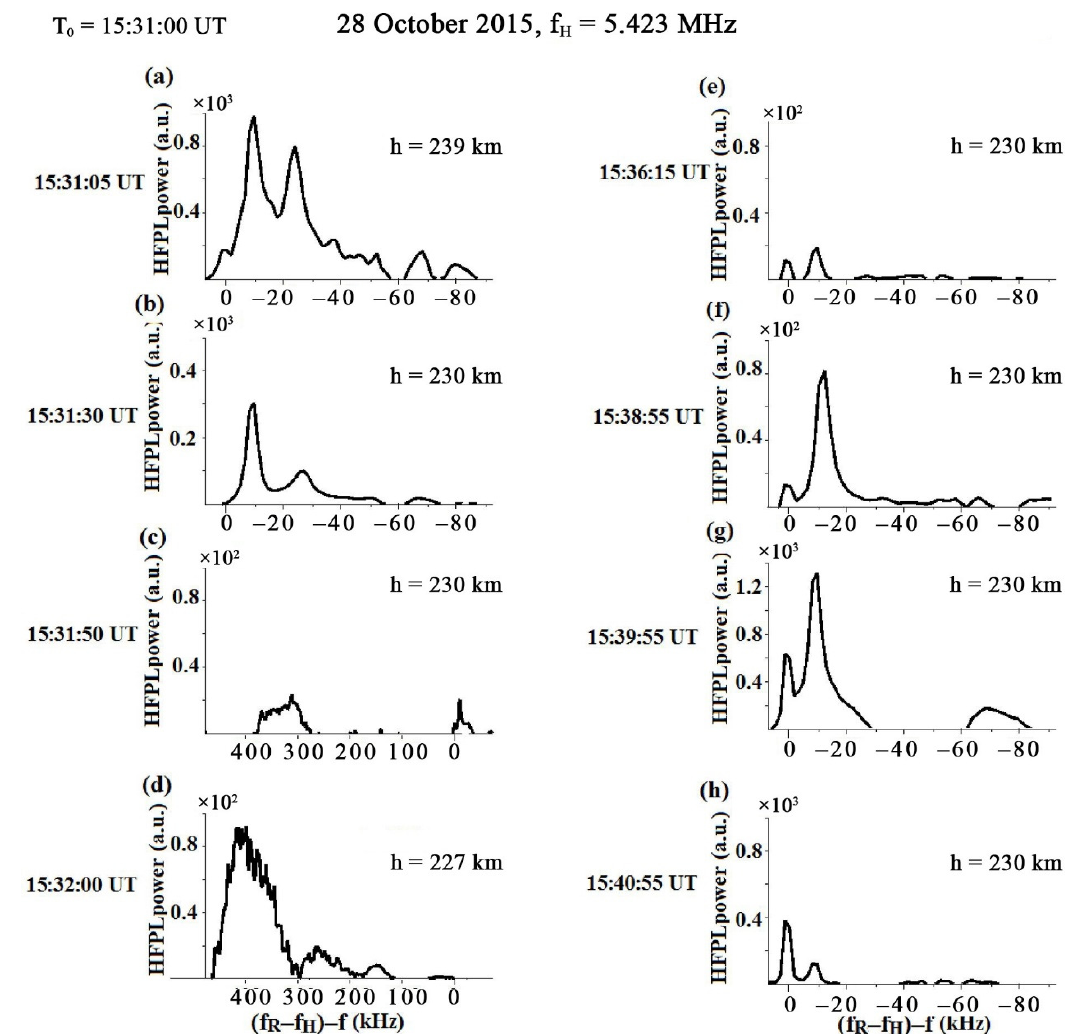
Figure 11. Spectra of HF-induced plasma lines taken with 5 s resolution at the altitudes of their maximum intensities during the “pure” O-mode pulse from 15:31 to 15:41 UT at ( a ) 15:31:05 UT, ( b ) 15:31:30 UT, ( c ) 15:31:50 UT, ( d ) 15:32:00 UT, ( e ) 15:36:15 UT, ( f ) 15:36:55 UT, ( g ) 15: 39:55 UT, ( h )